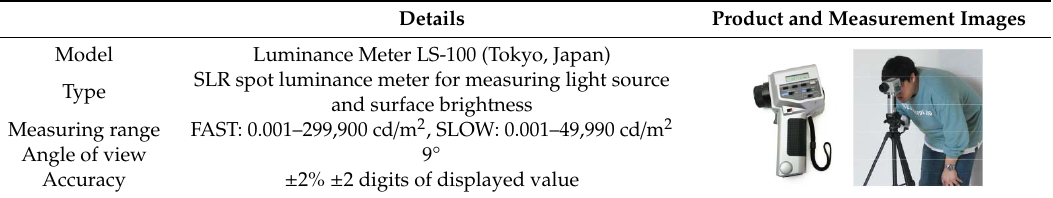
Figure 7. Glare measurement position and measurement spots. Table 6. Specifications and image of luminance meter.